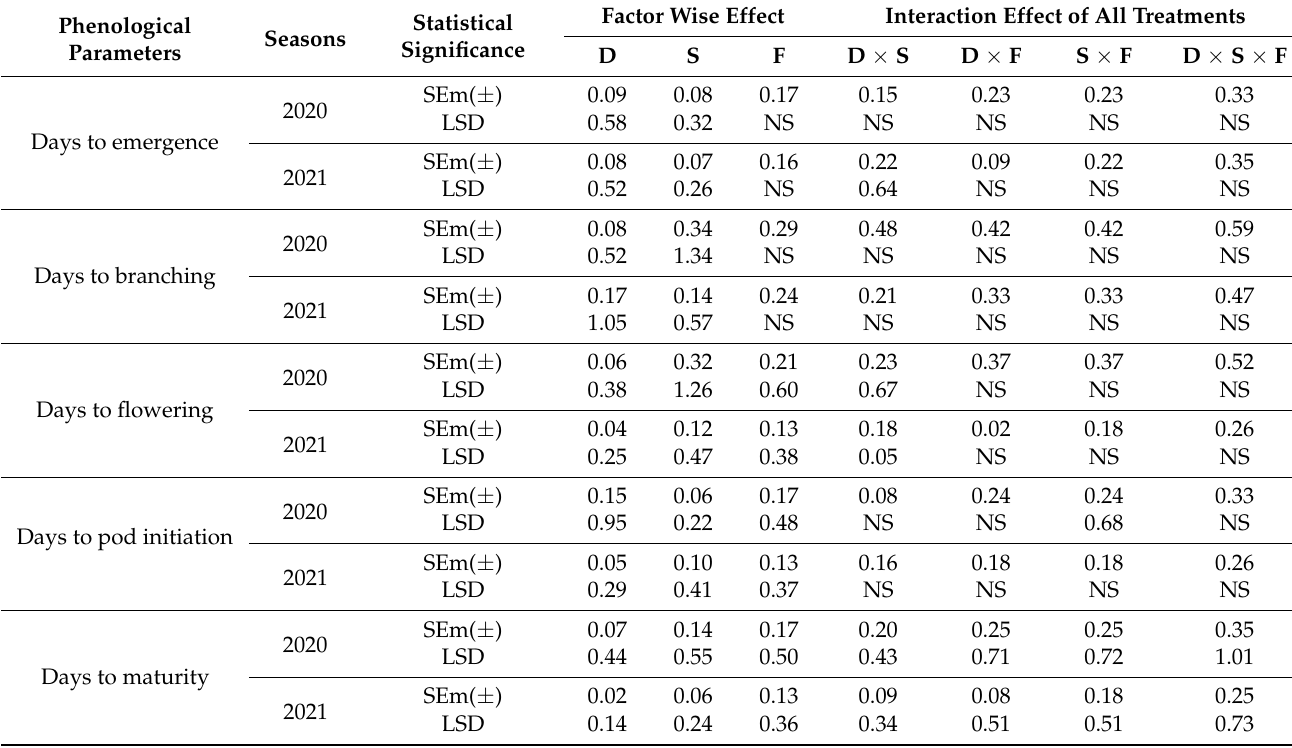
Table 4. Statistical significance and interaction effects of date of sowing, soil application of Co, and foliar spray of K and B on the phenology of black gram during the spring–summer season. Factor Wise Effect Statistical Phenological Seasons Significance Parameters